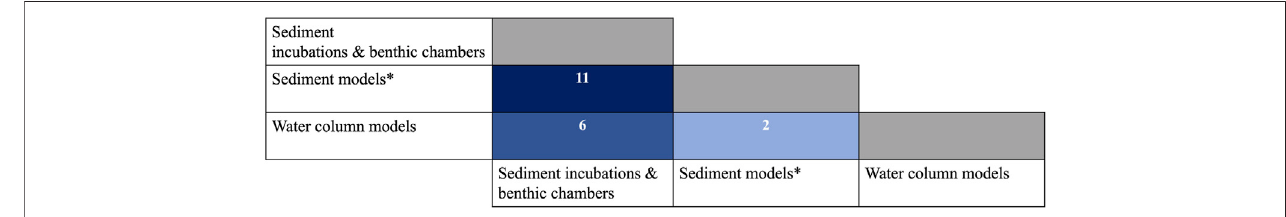
FIGURE 5 | Matrix showing number of studies that have compared multiple methodologies for calculating the diffusive fl ux of CH 4 from sediments. Blue boxes show number of existing studies, with lighter blue indicating fewer studies and darker blue indicating a larger number of studies. Asterisk indicates that there are n = 4 studies, notshowninthematrixhere,thatcompared fl uxesbetweentwosubtypesofsedimentmodels(diffusionanddiffusion-reactionmodels). Allcomparativestudies are identi fi ed in the Supplementary data fi le ( Supplementary Table S1 ).